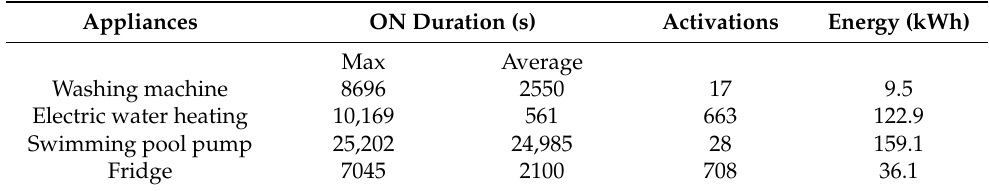
Table 3. Appliance statistics.